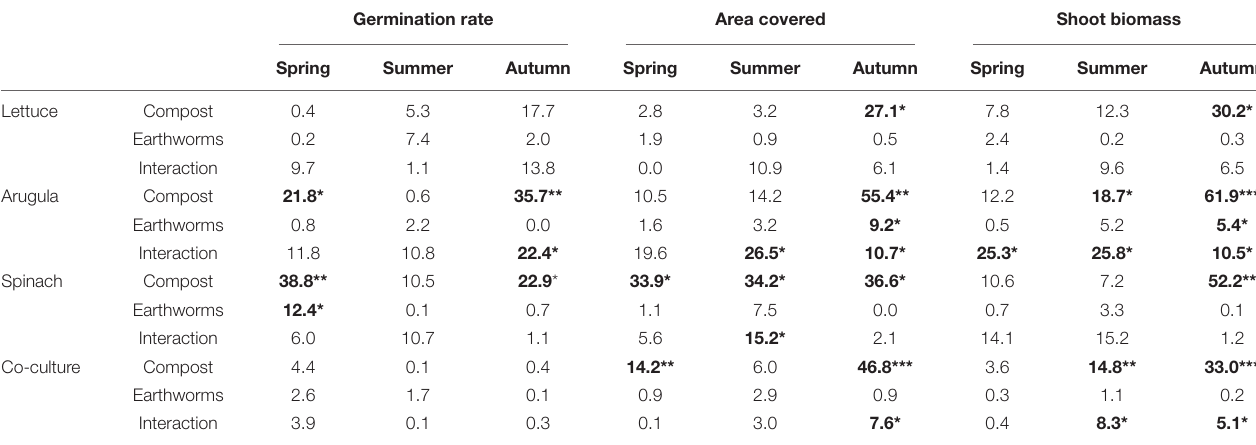
TABLE 1 | Proportion (%) of the variance explained by the relative amount of compost, the presence of earthworms and the interactions between the two latter factors for each monoculture and the co-culture of all plants ( n = 4). Germination rate Area